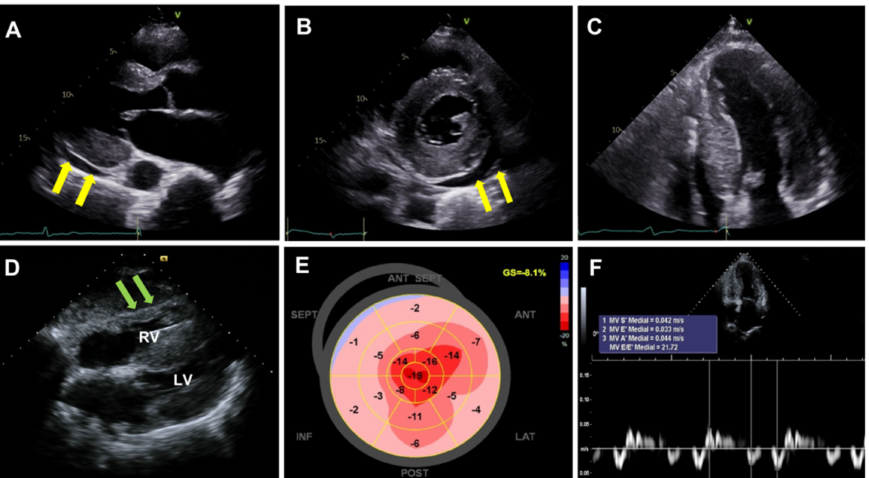
Figure 2. Echocardiographic findings of cardiac amyloidosis. ( A – C ): Thickened left ventricular wall ( ≥ 12 mm) with a granular sparkling appearance of myocardial texture and a small amount of pericardial effusion (yellow arrow), ( D ): right ventricular free wall hypertrophy (green arrow), ( E ): apical sparing of longitudinal strain (bull’s eye or cherry on top pattern), ( F ): deteriorated diastolic